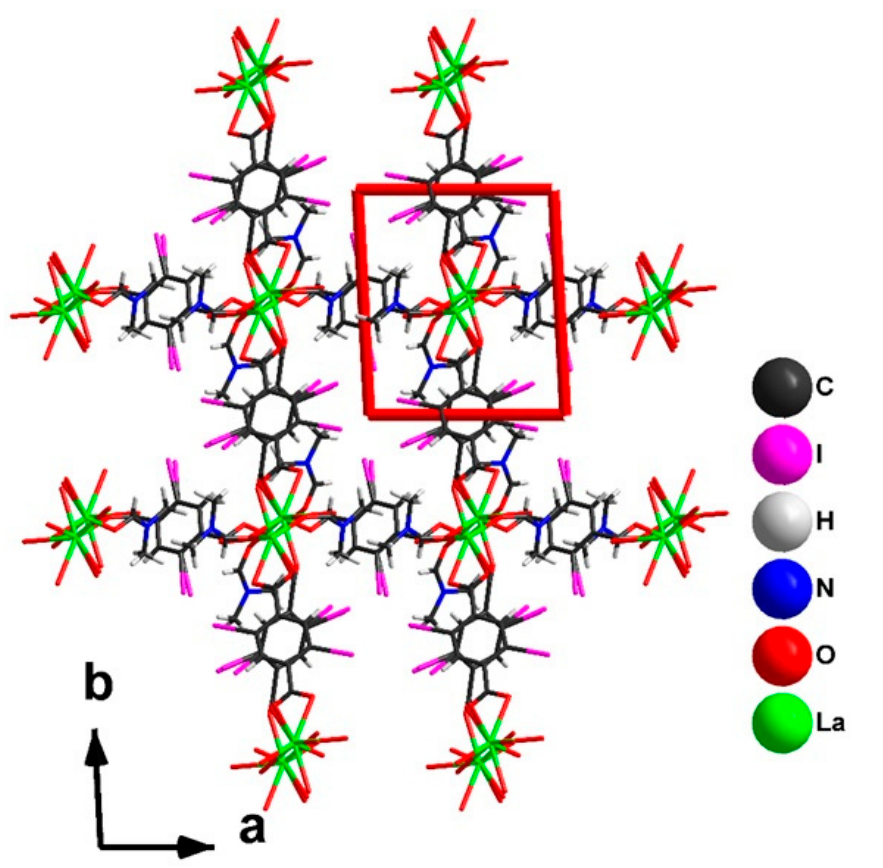
Figure 7. Crystal packing of 2 .